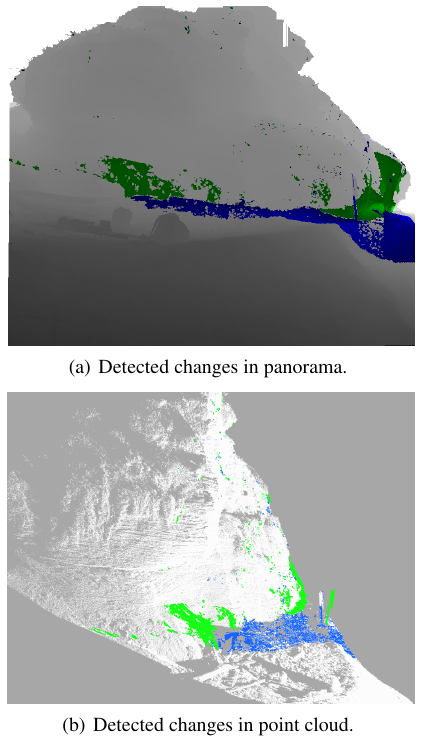
Figure 4: Changes along the Apollonia coastal cliff.